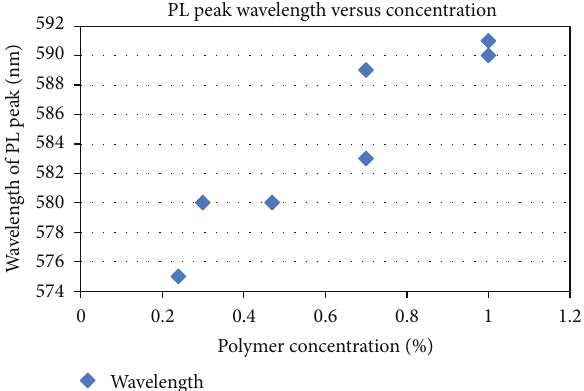
Figure 6: Photoluminescence peak wavelength of nanofibers as a function of the polymer concentration used to form the